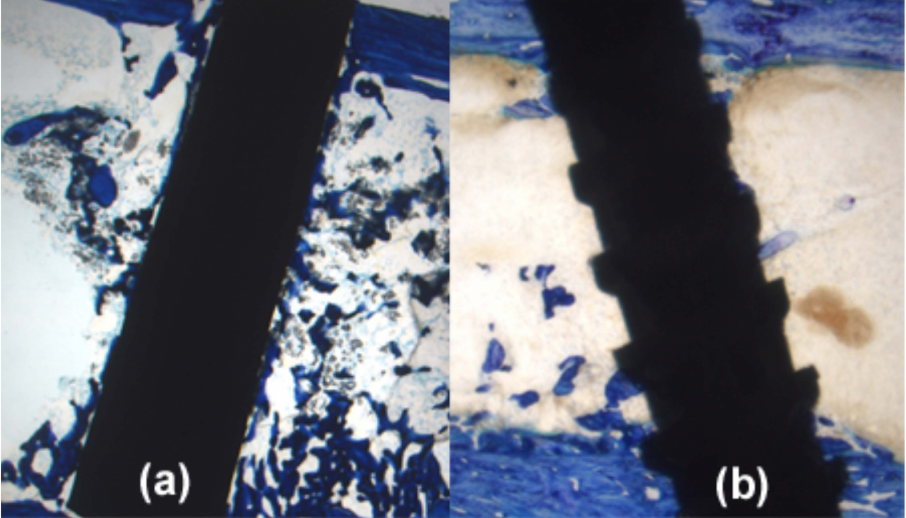
Figure 3. Lateral toluidine blue stain section 2X magnification rat tibia bone marrow and implant ( a ) Typical epoxy/carbon-fiber-reinforced composite; ( b ) Typical titanium-6Al-4V